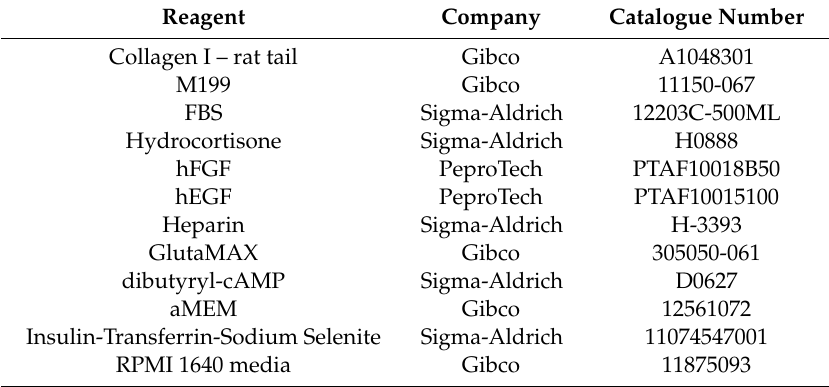
Table A1. Materials for cell